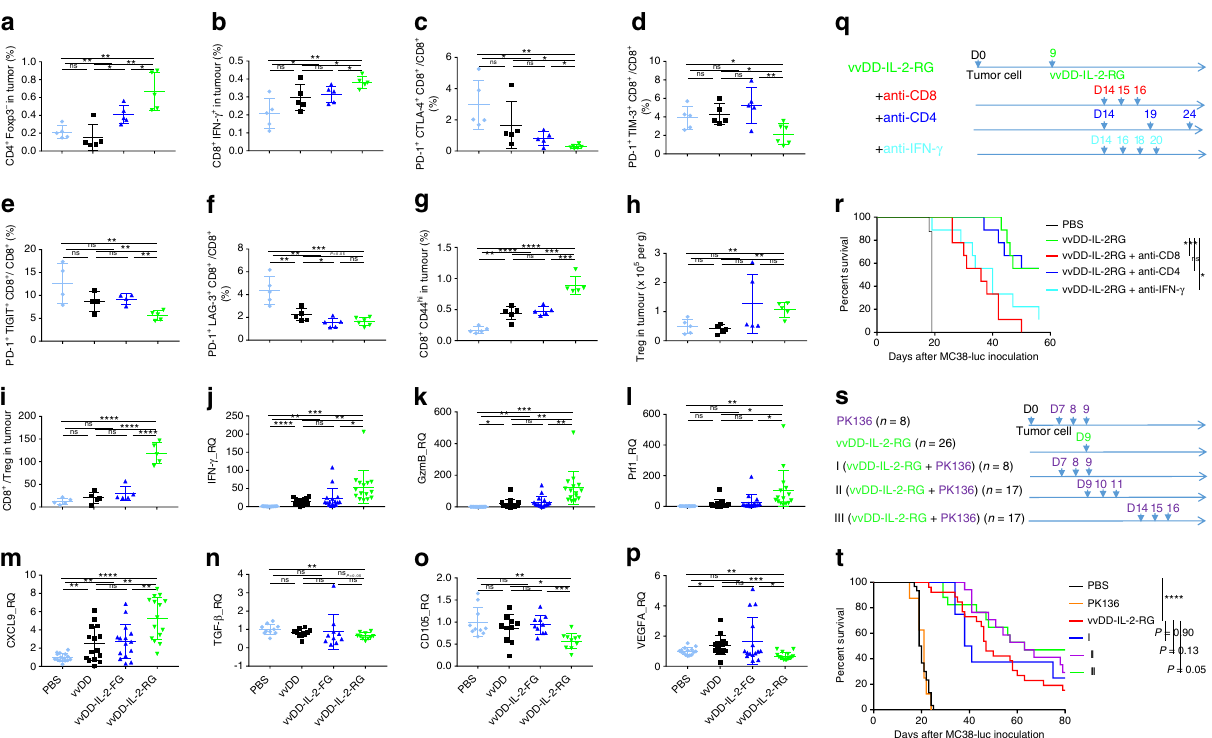
Fig. 3 Immune status change in the tumour microenvironment post-virus treatments. B6 mice were inoculated i.p. with 5 × 10 5 MC38-luc cells and treated with PBS, vvDD, vvDD-IL-2-FG, or vvDD-IL-2-RG at 2 × 10 8 PFU per mouse 9 days post-tumour inoculation. Tumour-bearing mice were sacri fi ced 5 days post-treatment and primary tumours were collected and analysed by fl ow cytometry to determine CD4 + Foxp3 - ( a ) and CD8 + IFN- γ + T cells ( b ), exhausted CD8 + T cell ( c – f ), memory-phenotype T cells (CD8 + CD44 hi ) ( g ), regulatory T cells (CD4 + Foxp3 + ) ( h ), CD8/Treg ( i ), or by RT-qPCR to determine IFN- γ